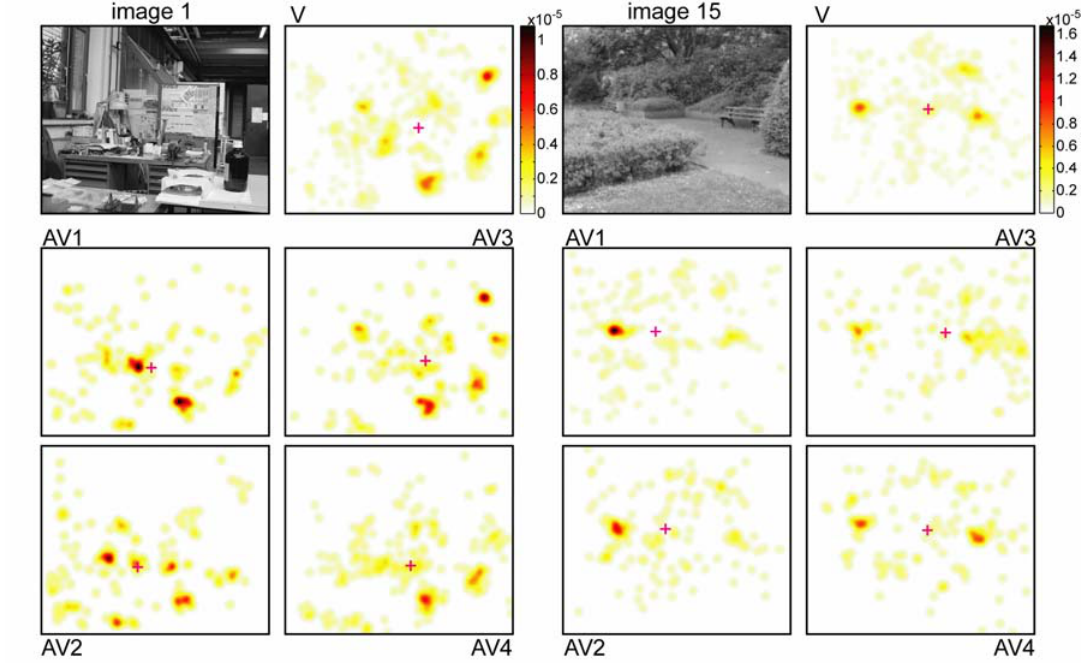
Figure 3. Data from two representative images. Two of the images used in the experiment are shown (original resolution was 1944 x 1600 pixels), along with the image pdfs constructed from eye movements of all subjects presented with this image in V and AV conditions. Probability of fixation is denoted by increasing colour; see colour bars provided with each image for corresponding scale (for visualisation purposes, V and AV pdfs are equalised to the same range). Centre of gravity of each pdf is indicated by a